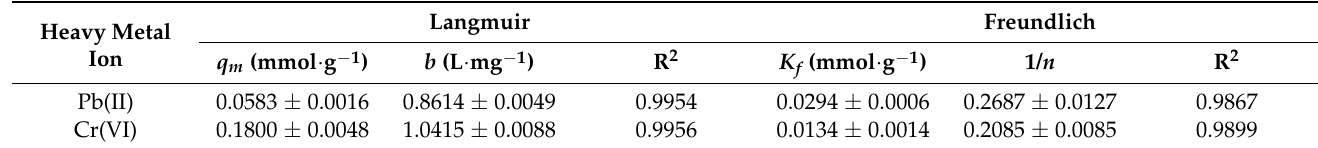
Table 3. Adsorption parameters of the Langmuir and Freundlich isotherms at room temperature for the adsorption of Pb(II) and Cr(VI).